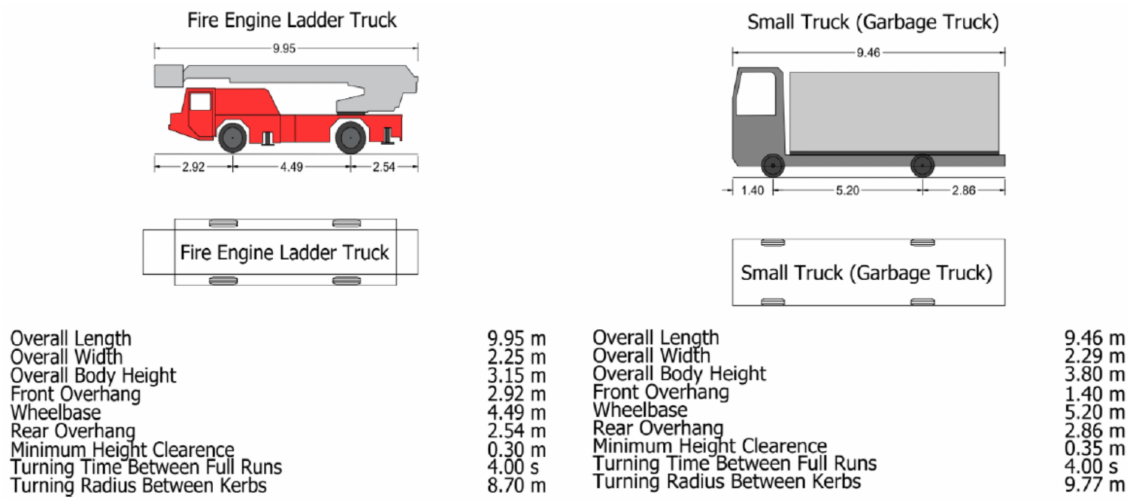
Figure 8. Technical parameters of the fire engine ladder truck and the garbage